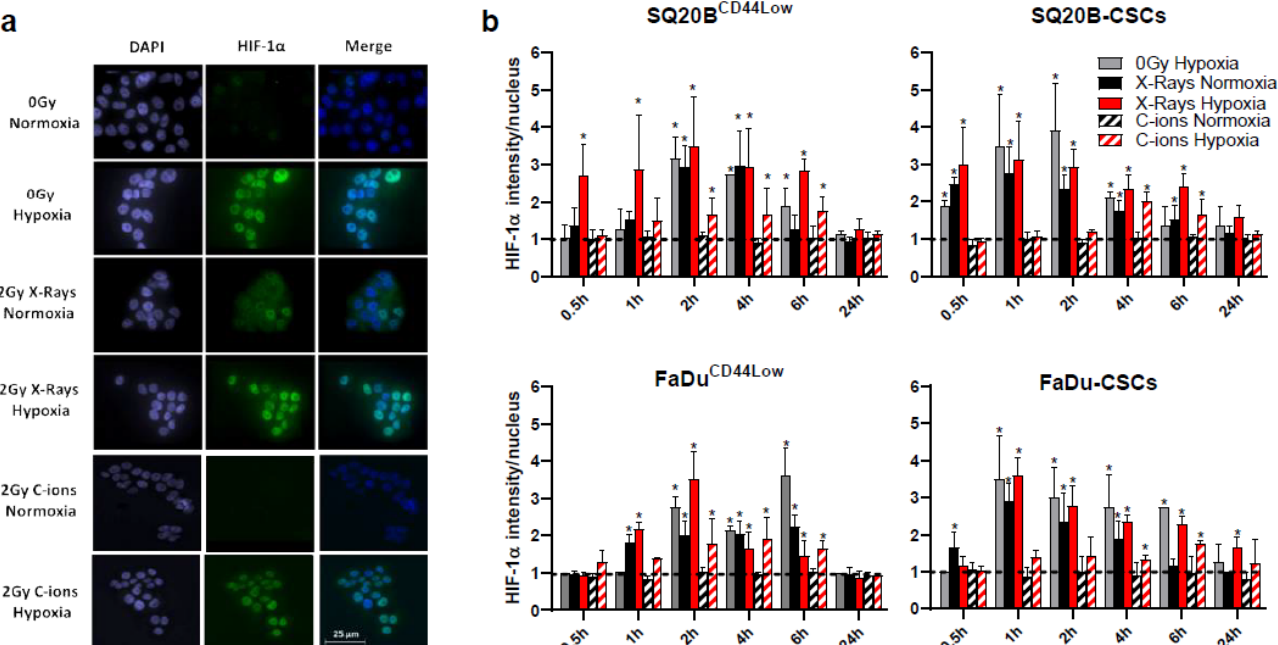
Figure 1. HIF-1 α nucleoshuttling is induced by photons under normoxia and hypoxia, but only under hypoxia with C-ions ( a ) Representative images at 4 h of SQ20B CD44Low cells (0 or 2 Gy photons and C-ions, under normoxia or hypoxia) are presented with the indicated biomarkers. ( b ) Signal intensities of HIF-1 α into the nucleus were measured for each condition and normalized to basal signal. The means ± SD were statistically compared to the basal ratio. (Student’s t -Tests using Holm–Sidak method, α = 0.5). ( n = 3 photons; n = 2 C-ions). * p < 0.05.